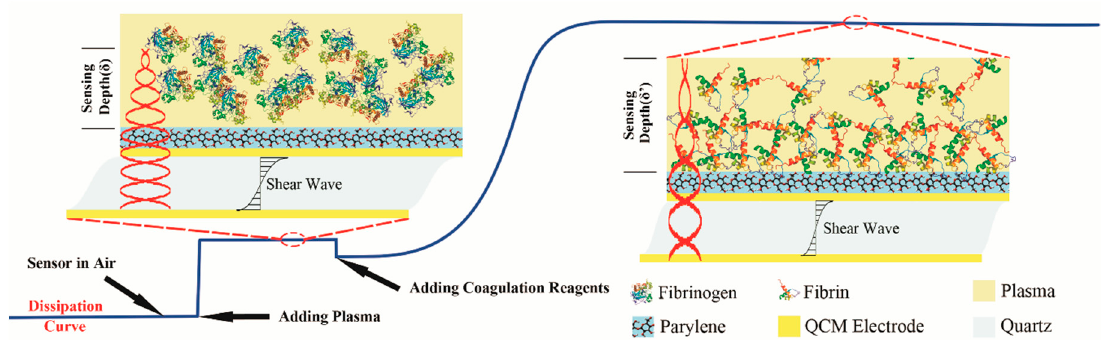
Figure 2. Quartz Crystal Microbalance (QCM) dissipation based coagulation measurement principles.